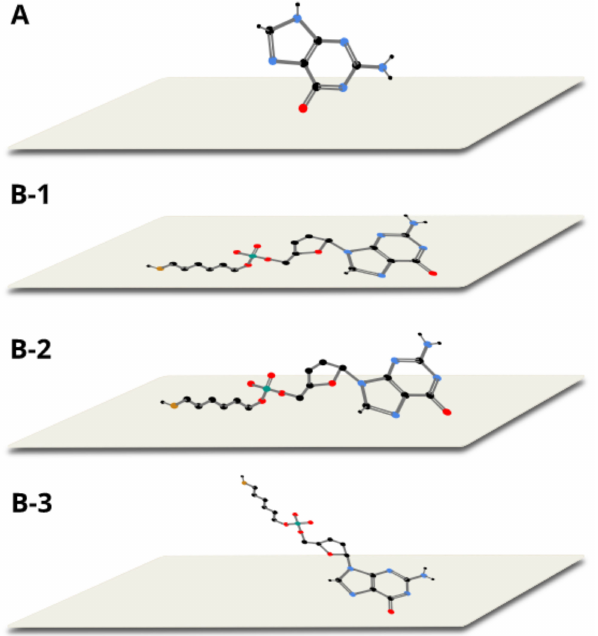
Figure 10. Proposed orientation of guanine ( A ) and thiolated guanine mononucleotide ( B 1–3 ) on gold colloidal